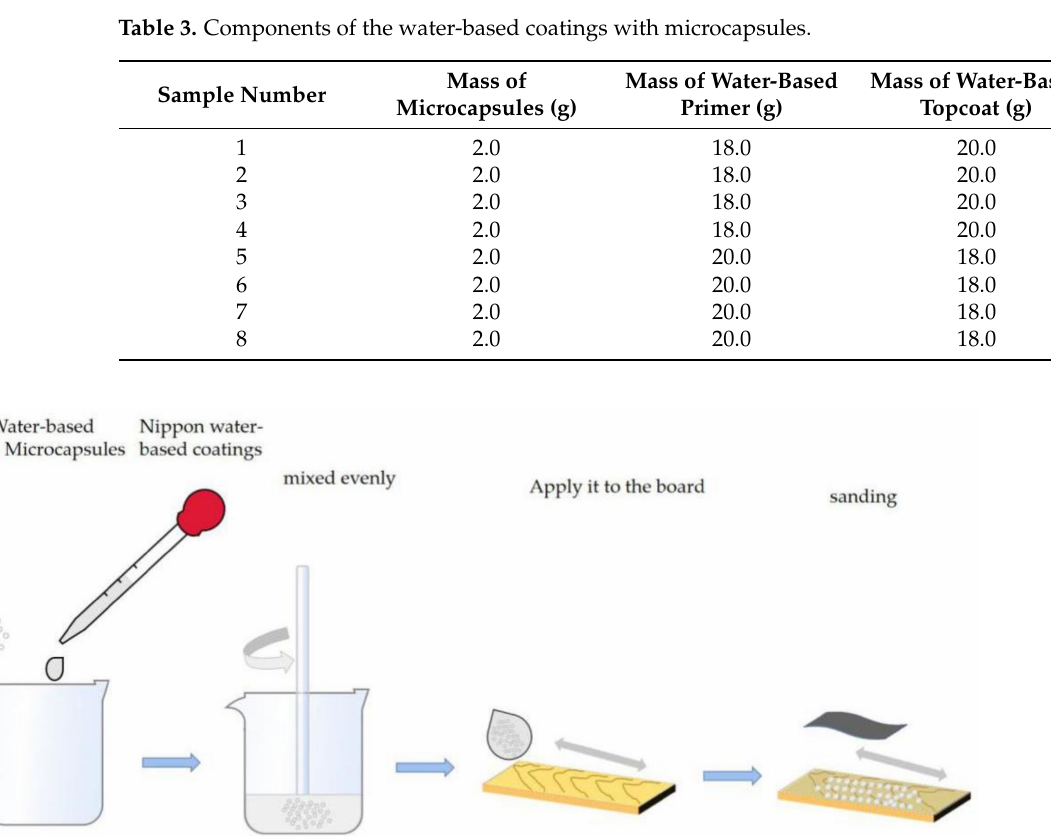
Figure 1. Diagram of Nippon water-based coatings added with water-based emulsion